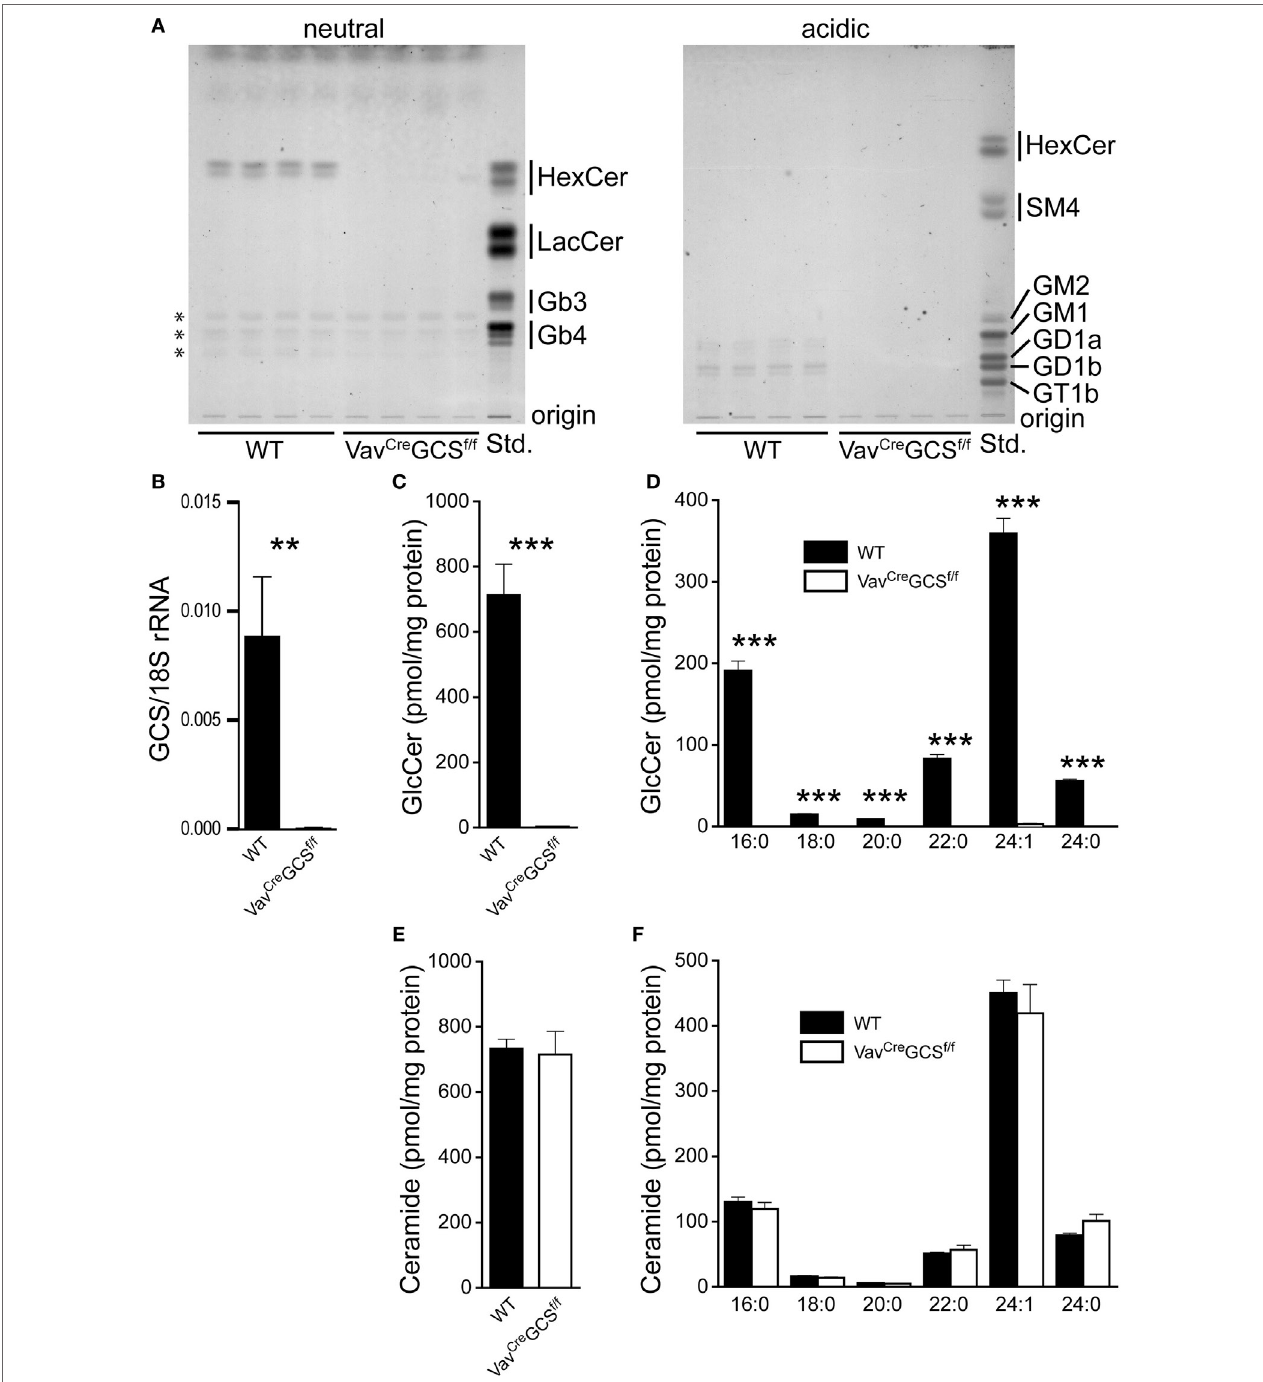
FigUre 3 | Glycosphingolipid (GSL) depletion in Vav Cre GCS f/f double-positive (DP) thymocytes. (a) GSL were extracted from enriched DP thymocytes from 8-week-old wild-type (WT) and Vav Cre GCS f/f mice, separated into neutral and acidic fractions and analyzed by thin layer chromatography. In DP thymocytes from Vav Cre GCS f/f mice, no residual GSL could be detected. The substances in the neutral fraction marked by asterisks do not show the typical orcinol color for GSL and therefore very unlikely represent those compounds. Shown are results from four different experimental animals per group. (B) FACS-sorted DP thymocytes were analyzed for the expression of GlcCer synthase (GCS) by quantitative PCR. The expression was normalized to 18S rRNA. Shown are means ± SEM, N = 7 per group. (c–F) GSL were extracted from FACS-sorted DP thymocytes. The content of GlcCer (c,D) and ceramide (e,F) was quantified by mass spectrometry and normalized for the protein amount in the sample. Panels (c,e) show the total amount of GlcCer and ceramide, respectively. In panels (D,F) , the composition of acyl moieties of GlcCer and ceramide, respectively, are displayed. Some of the bars for Vav Cre GCS f/f are barely visible due to very low levels. Shown are means ± SEM, N = 6 and 7 per group, respectively. Statistically significant differences between WT and Vav Cre GCS f/f mice are indicated: ** p < 0.01; *** p < 0.001.